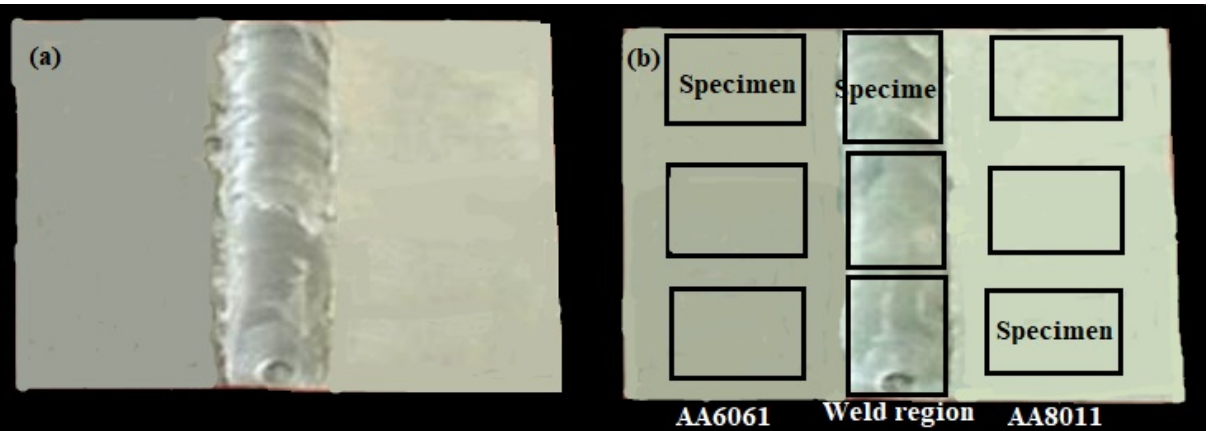
Figure 3. ( a ) Friction-stir-welded specimen and ( b ) corrosion specimens marked within a welded specimen.